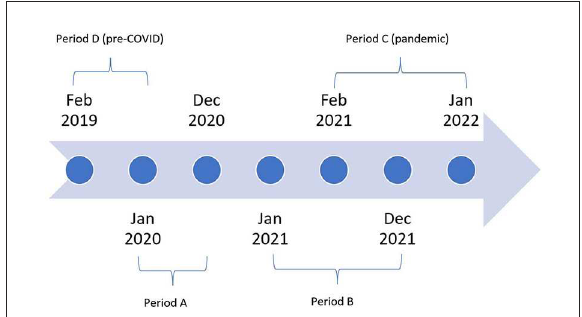
FIGURE1 Study timeline: Period A (calendar year 2020), Period B (calendar year 2021), Period C (pandemic period = February 2021 to January 2022), and Period D (pre-COVID = February 2019 to January